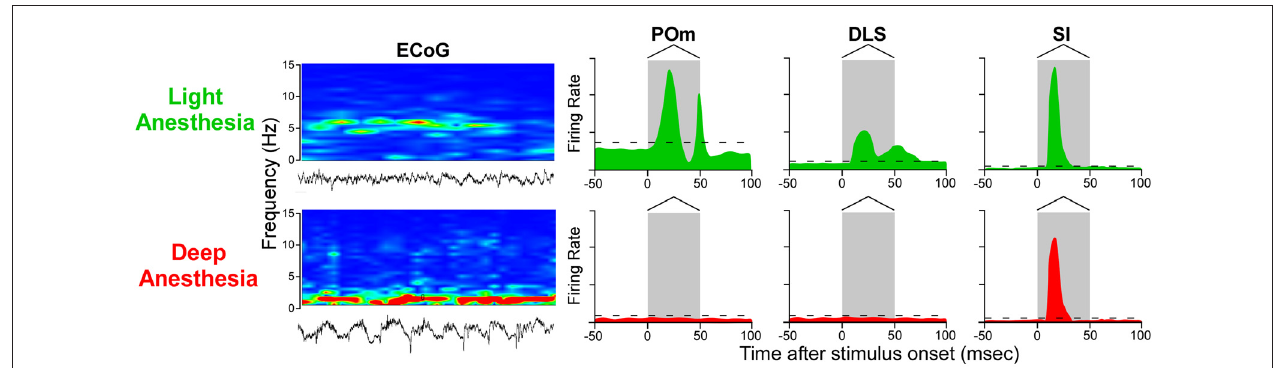
FIGURE 7 | Stimulus-induced responses in POm, DLS and SI cortex as a function of behavioral state. In the lightly-anesthetized state, when electrocorticographic (ECoG) activity is 4–6 Hz, neurons in POm, DLS and SI display strong phasic responses to back-and-forth whisker deflections. When ECoG activity is dominated by frequencies below 1 Hz, however, neurons in POm and DLS are unresponsive, but neurons in SI cortex still display rapidly-adapting responses. Responses in the idealized peristimulus time histograms (PSTHs) are based on studies that examined the effects of anesthesia and other behavioral states on somesthetic